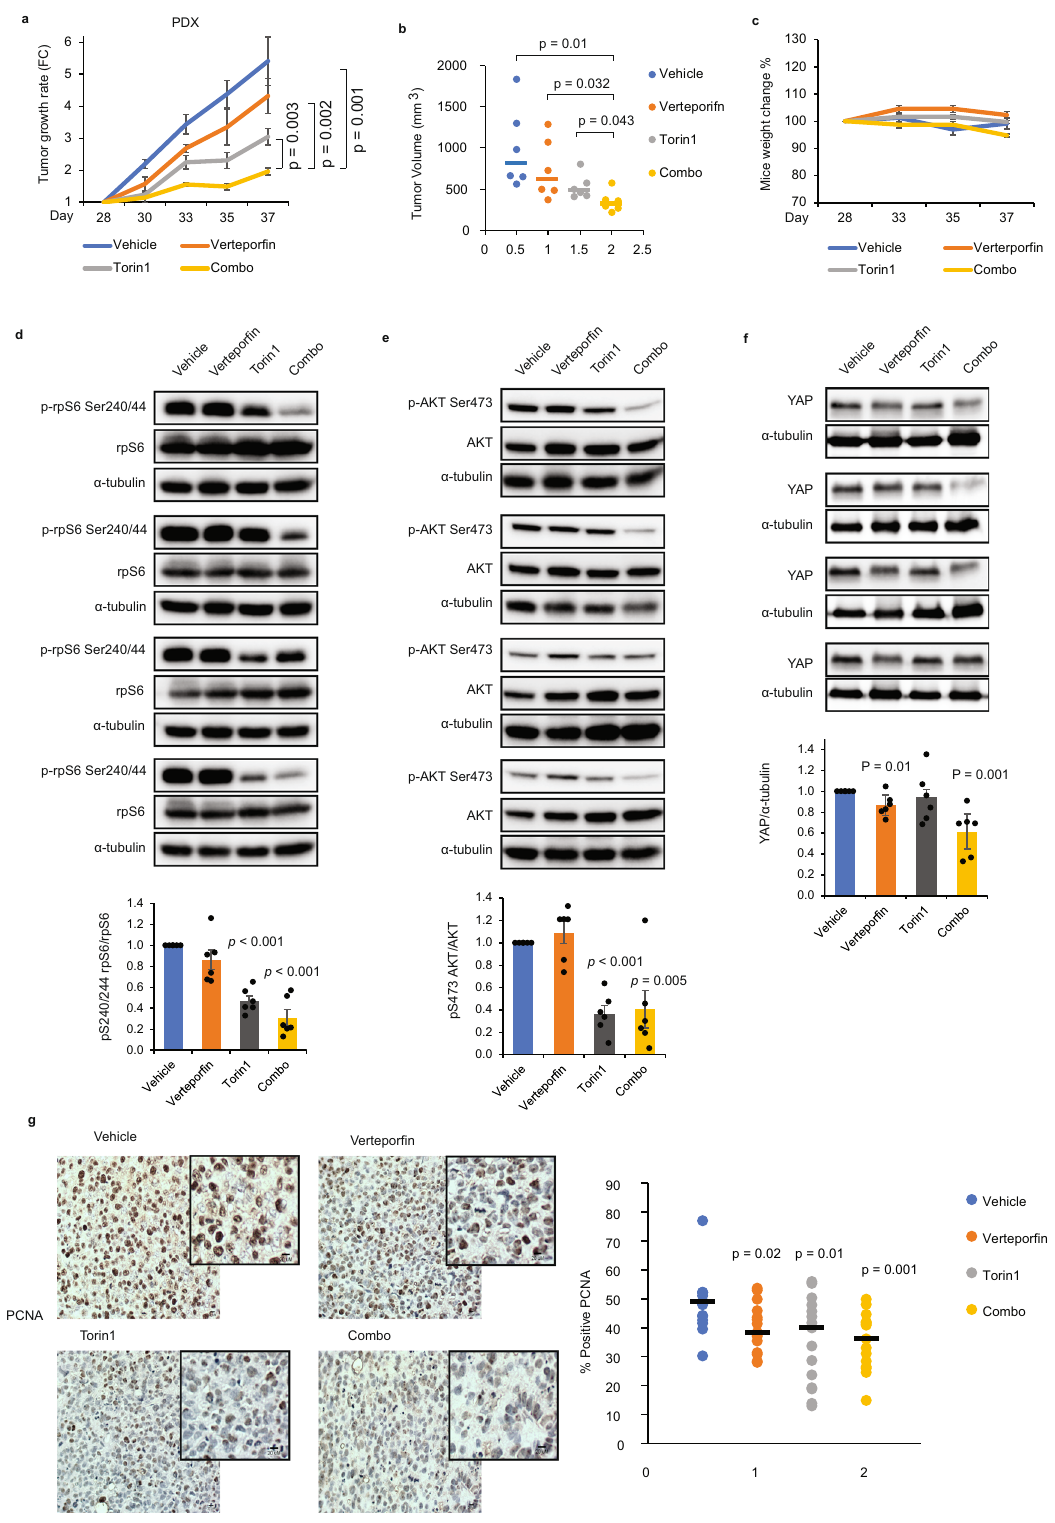
− 20 °C. For PCR2, 8 reactions were performed for each sample in a total 100 µL volume (20µL Herculase 5× Buffer, 1µL of 100 mM dNTP, 2.5µL of Adapter Primer F, 2.5µL of Adapter Primer R, 1 µL Herculase II Fusion Enzyme, 5µL of PCR1 amplicon and 68µL of PCR grade water). PCR2 reactions were performed as described for PCR1. Final PCR products were run on a 2% gel and extracted and puri fi ed using the QIAquick PCR & Gel Cleanup Kit (Qiagen) and subjected to next generation sequencing by Quebec Genome Center. 80 cycle and 20 million reads for each sample were performed by Hiseq 2500.